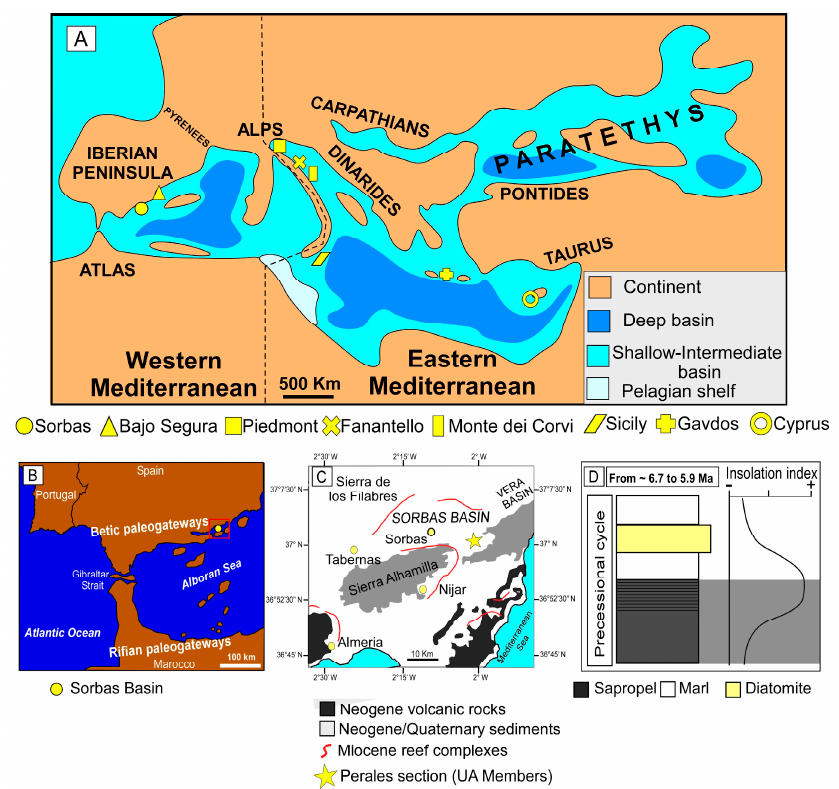
Figure 3. ( A ): Messinian paleogeography of the Mediterranean with the principal localities in which sapropels were recorded. Modified after [52]. Data from [19,40,47–49,51,53–55]. ( B ): Sorbas Basin paleogeographic location from ~6.7 to 5.9 Ma, modified after [56,57]. ( C ): Geological map of south- east Spain showing the location of the studied interval. ( D ): Basic sedimentary cycle of the Sorbas Basin recording precessional footprint and its relationship with insolation index [58].